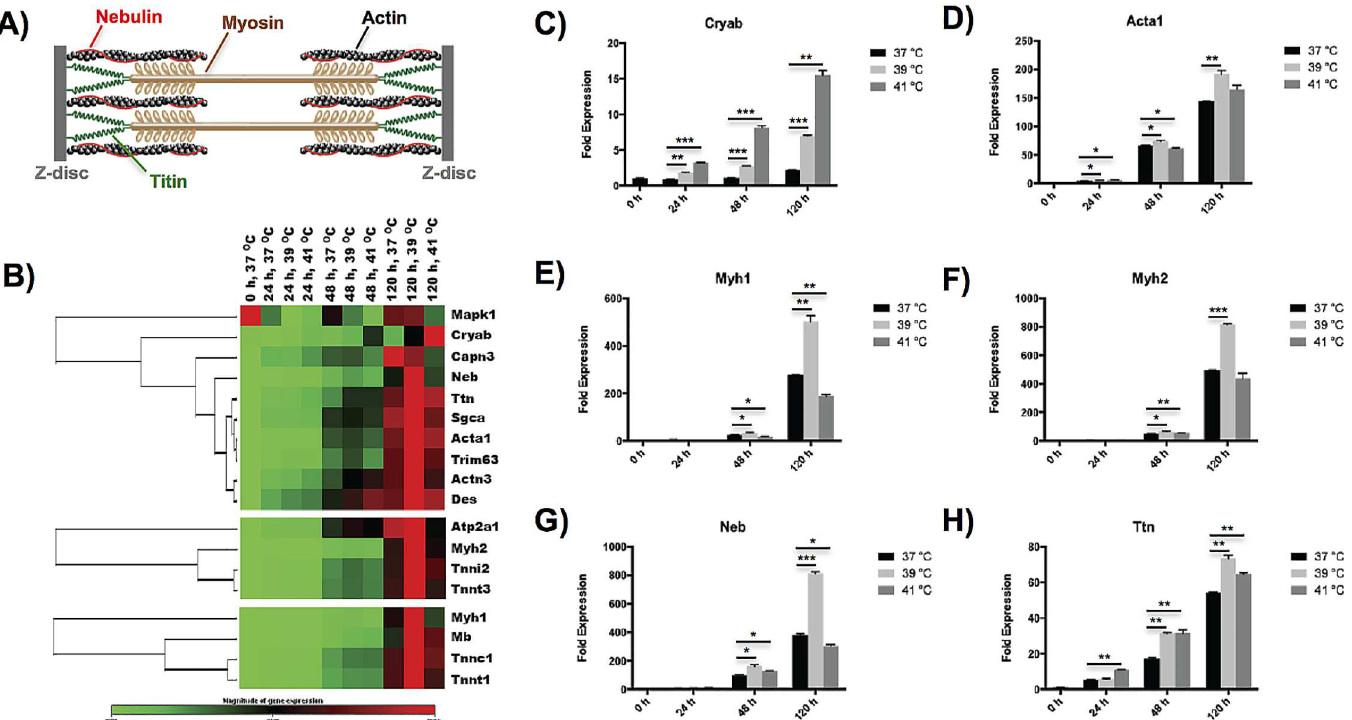
Fig 3. Effects of hyperthermia treatment on myofibrillogenesis of C2C12 myoblasts during myogenic differentiation. (A) Schematic of a sarcomere segment in myofibril containingvarious important proteins, includingactin, myosin, nebulinand titin. (B) Clustergram of myofibrillogenesis genes, including genes associated with titin complex (top), fast-twitch fibers (middle), and slow-twitch fibers (bottom), showingtime- and temperature-dependences on hyperthermia treatment during myogenic differentiation. (C-H) Characteristic myofibrillogenesisgenes represented in bar figures. The error bars in (C-H) represent the standard deviationof the mean, and the myotubes cultured at 37˚C were used as a control. All statistical differences against the control are indicated. * p < 0.05, ** p < 0.01, *** p < 0.001.